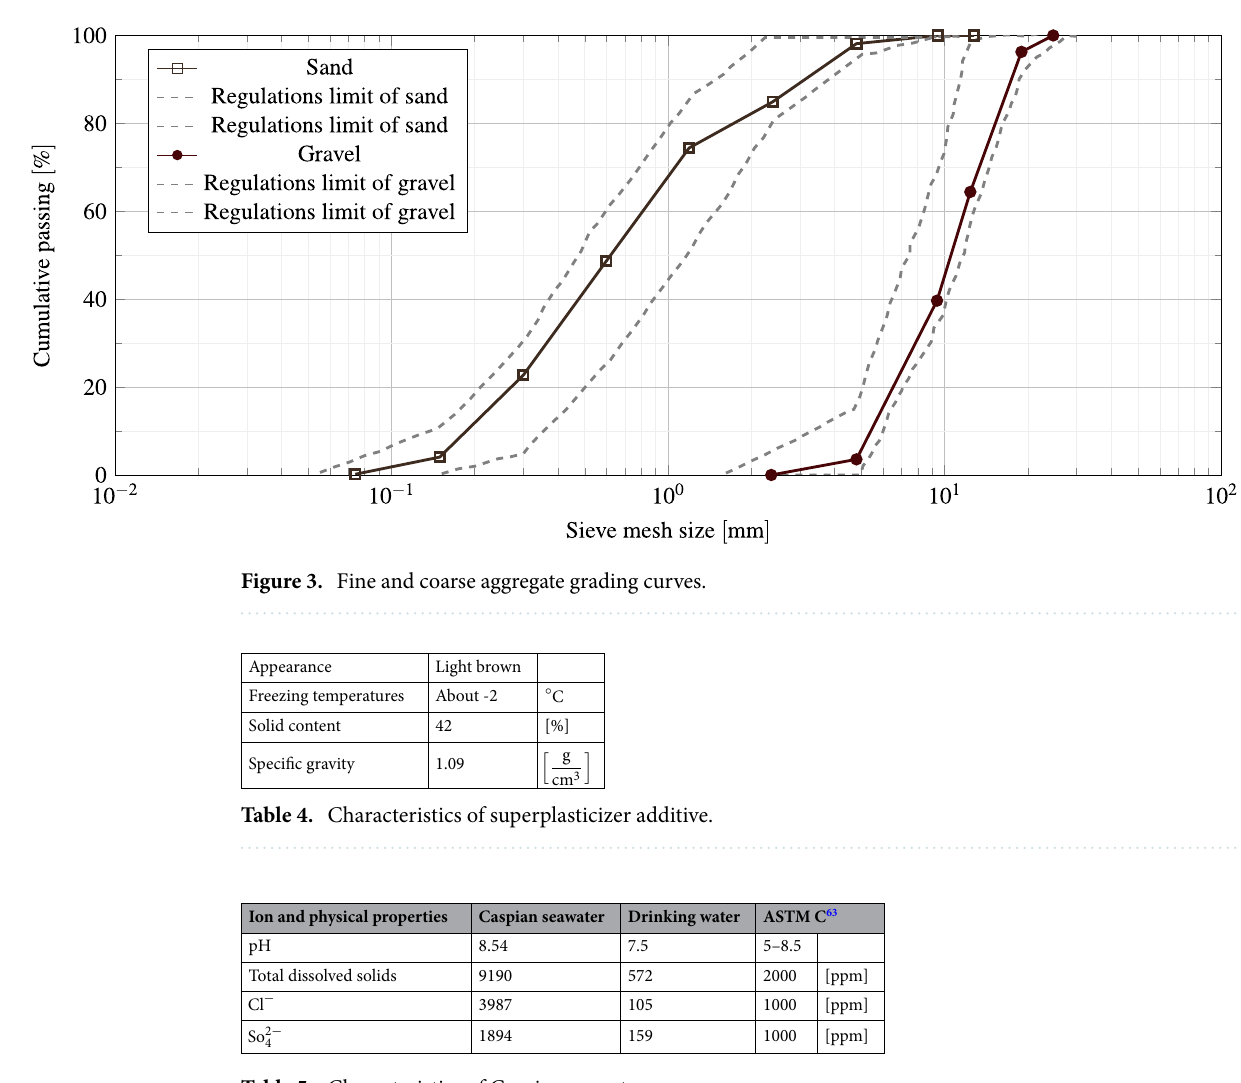
Table 5. Characteristics of Caspian